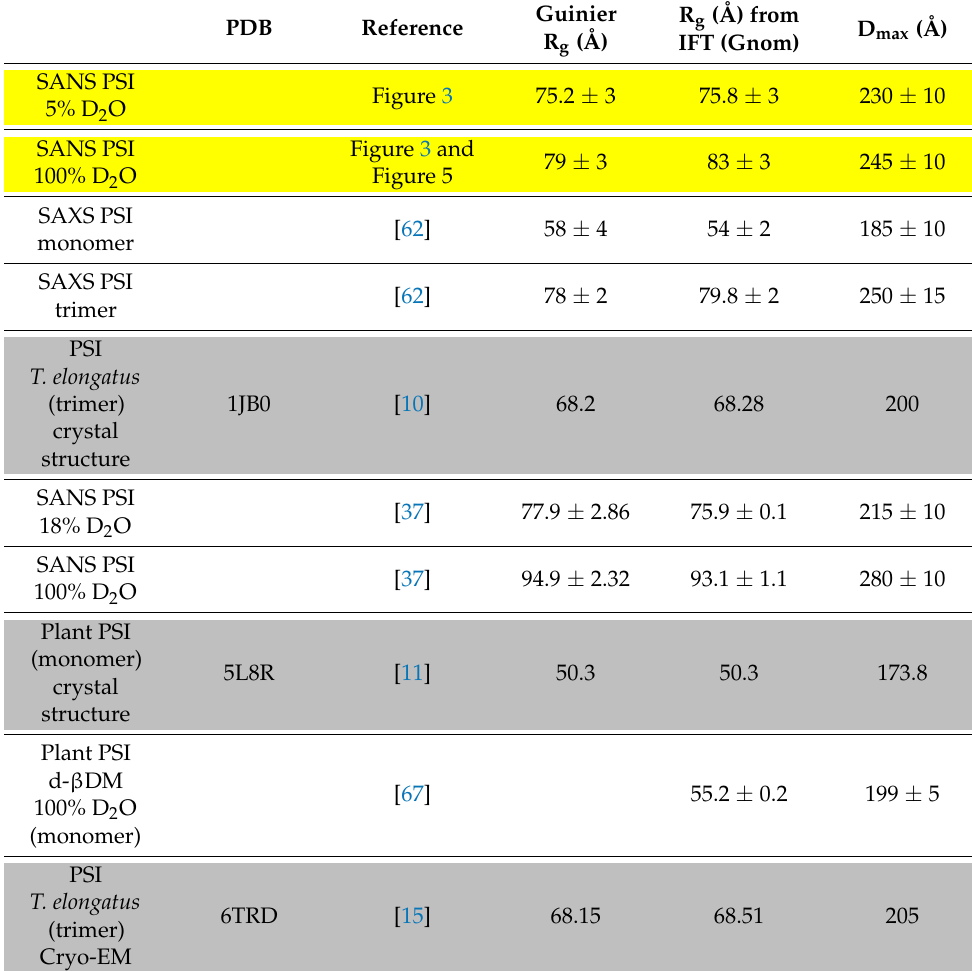
Table 2. Comparison of parameters R g and D max obtained at different contrasts in this work with literature values. Values of this study are highlighted in yellow; values obtained from crystal structures are marked in